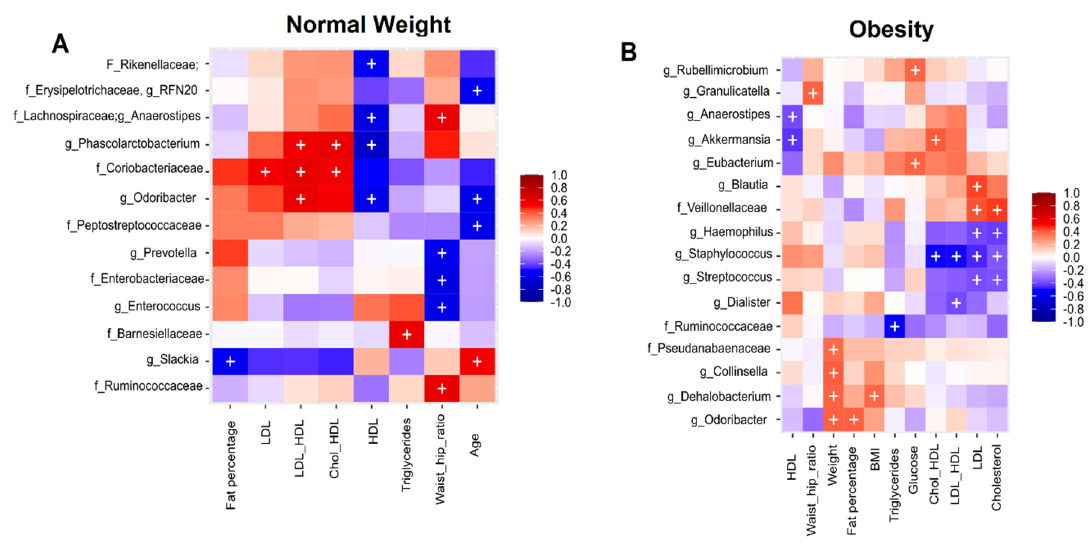
Figure 6. Spearman correlations of clinical metadata and bacterial abundance during nopal diet in- tervention. ( A ) Correlation in the normal weight group ( B ) Correlation in the obesity group. The heat map shows correlation between bacterial taxa and numerical metadata. Columns show the nu- merical metadata. Rows show the bacterial taxa. The color key from blue to red indicates the corre- lation value between − 1 to +1; − 1 indicates negative correlation and +1 positive correlation. The sym- bol “+” denotes a significance of p < 0.05.